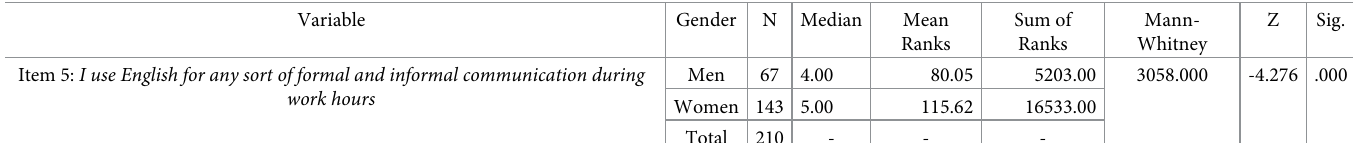
Table 10. Mann-Whitney test.